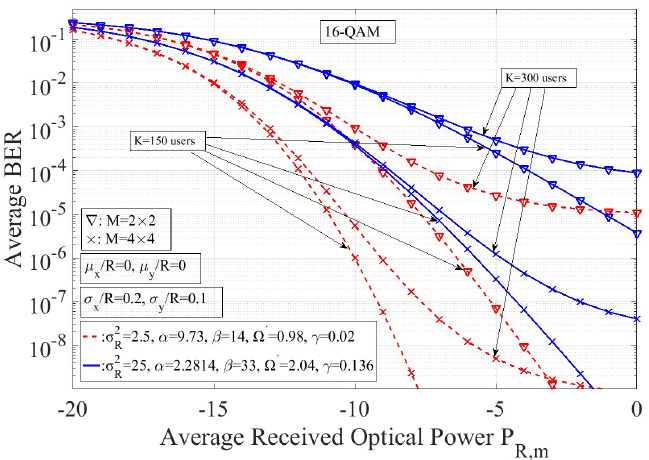
Figure 3. The ABER performance for the forward CDMA RoFSO link with receivers’ diversity, over strong turbulence and weak PE impact for different values of the number of users K .